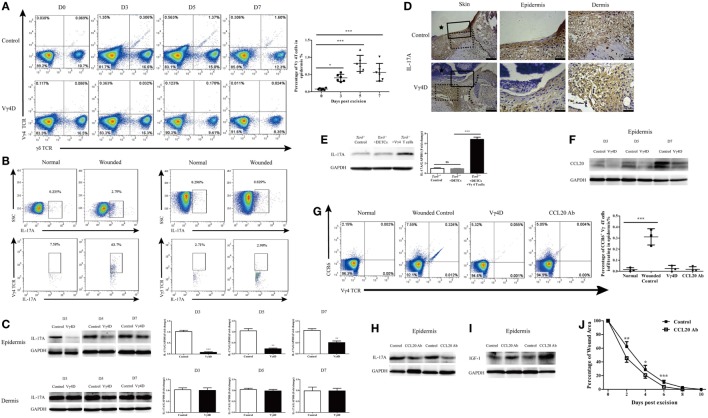
Vγ4 T cells via CCR6-CCL20 pathway infiltrated into epidermis and provided major early source of epidermal IL-17A after wounding. (A) Vγ4 T cells in epidermis around wound of Vγ4 T-cell depletion (Vγ4D) and wild-type (WT) mice were analyzed by FACS on days 0, 3, 5, and 7 after skin injury (4 wounds/mice, 5–7 mice/group). (B) Epidermis infiltrating IL-17A-positive cells around wound of WT mice (4 wounds/mice, 3–5 mice/group) were analyzed by FACS on days 0 and 3 after skin injury (upper panel). Gated on IL-17A-positive cells, the percentage of Vγ4 T cells and dendritic epidermal T cells (DETCs; anti-Vγ5 TCR) are shown (lower panel). (C) The expression of IL-17A in epidermis around wound of Vγ4D and WT mice was analyzed by WB on days 3, 5, and 7 after skin injury (n = 3–5/group). (D) The expression of IL-17A in epidermis around wound of Vγ4D and WT mice was analyzed by IHC on day 3 post-excision (n = 3–5/group). The area of wound and neo-epidermis is marked by black star (Skin, left panel). Neo-epidermis in solid rectangles and neo-dermis in dashed rectangles are shown on the middle (Epidermis) and right (Dermis) panel. (E) Fresh isolated WT DETCs (5 × 104 cells/wound), Vγ4 T cells (1 × 104 cells/wound), or PBS was added onto wound bed of Tcrδ−/− mice immediately after skin injury (n = 3/group). On day 3 post-excision, the production of IL-17A in epidermis around wound was determined by WB. (F) The expressions of CCL20 in epidermis around wound of Vγ4D and WT control mice were detected by WB on days 3, 5, and 7 after wounding (n = 3/group). (G) Addition of CCL20 neutralizing Ab (10 μg/per wound) onto wound bed of Vγ4D and WT control animals at day 0, 1, and 2 after skin injury. On day 3 post-excision, the expressions of CCR6 on surface of Vγ4 T cells in epidermis around wound of animals with Vγ4D, CCL20 neutralizing, or control isotype Abs treatment were detected by means of FACS (4 wounds/group, 3 mice/group). (H–J) Addition of CCL20 neutralizing Ab (10 μg/wound) or isotype Ab (rat IgG1) into wound margin on days 0, 1, and 2 after skin injury. The production of IL-17A (H) and IGF-1 (I) in epidermis around wound was analyzed by WB on day 3 after wounding (n = 3–5/group). (J) Wound-closure kinetics was measured over time and dots in wound closure kinetics represent 10 wounds per group (2 wounds/mouse, 5 mice/group). Bars represent mean ± SD. All data were representative of three independent experiments. P value was determined by one-way ANOVA with Bonferroni’s comparision test (A,E,G) or Student’s unpaired t-test (C,J) (*P < 0.05, **P < 0.01, ***P < 0.001).